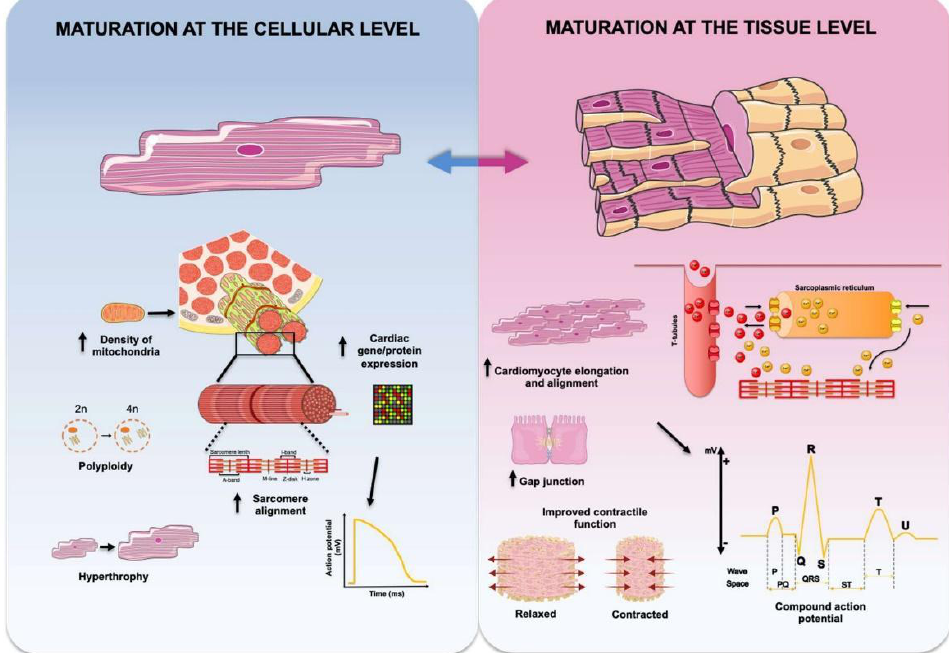
Figure 2. General features of cardiac maturation at the cellular and tissue levels. Cardiac maturation at the level of cardiomyocytes (blue-shaded background) can be experimentally ascertained by a more adult-like cardiac gene expression profile, changes in sarcomeric ultrastructure resulting in sarcomere elongation and alignment, increased mitochondrial density to accommodate for higher energy demand, and massive growth in cardiomyocyte size (hypertrophy) with increased percentage of polyploid cells. Electrophysiologically, cardiomyocyte maturation results in a more negative resting membrane potential and increased duration and amplitude of action potential. Cardiac maturation at the tissue level (pink-shaded background) is characterized by elongated cardiomyocytes preferentially aligned along a specific axis, increased expression of Cx43 and distinct localization of gap junction proteins, and improvements in impulse propagation and synchronization of cardiac contraction, leading to cardiomyocytes performing as a functional syncytium. Maturation at the tissue level results in increased contractility and force generation and, electrophysiologically can be registered as compound action potentials reminiscent of surface ECG recordings. Figure created with BioRender.com and smart.servier.com.